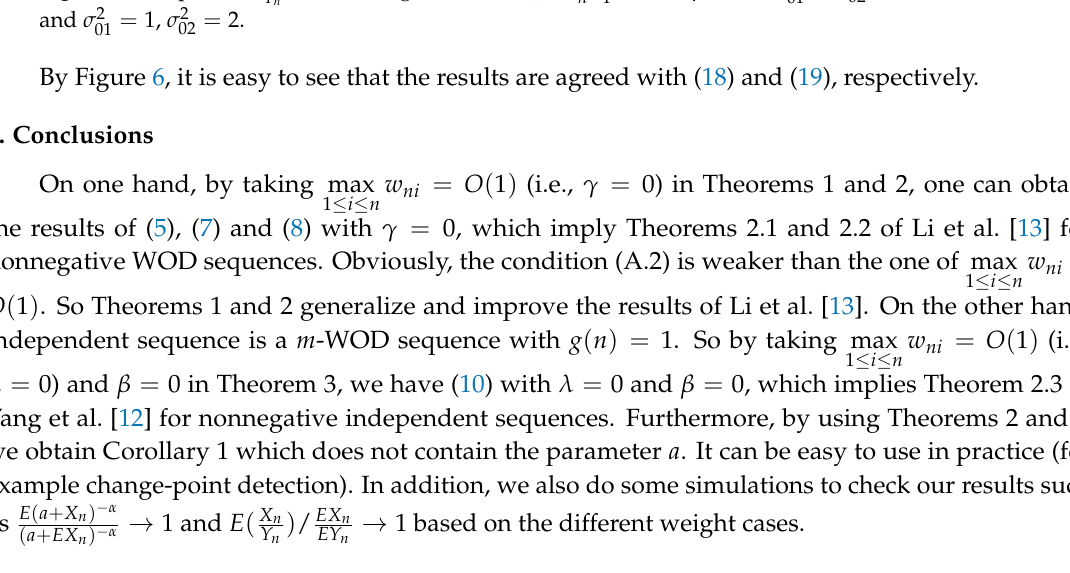
= σ 2 = 1, or k ∗ = n /2 02 01